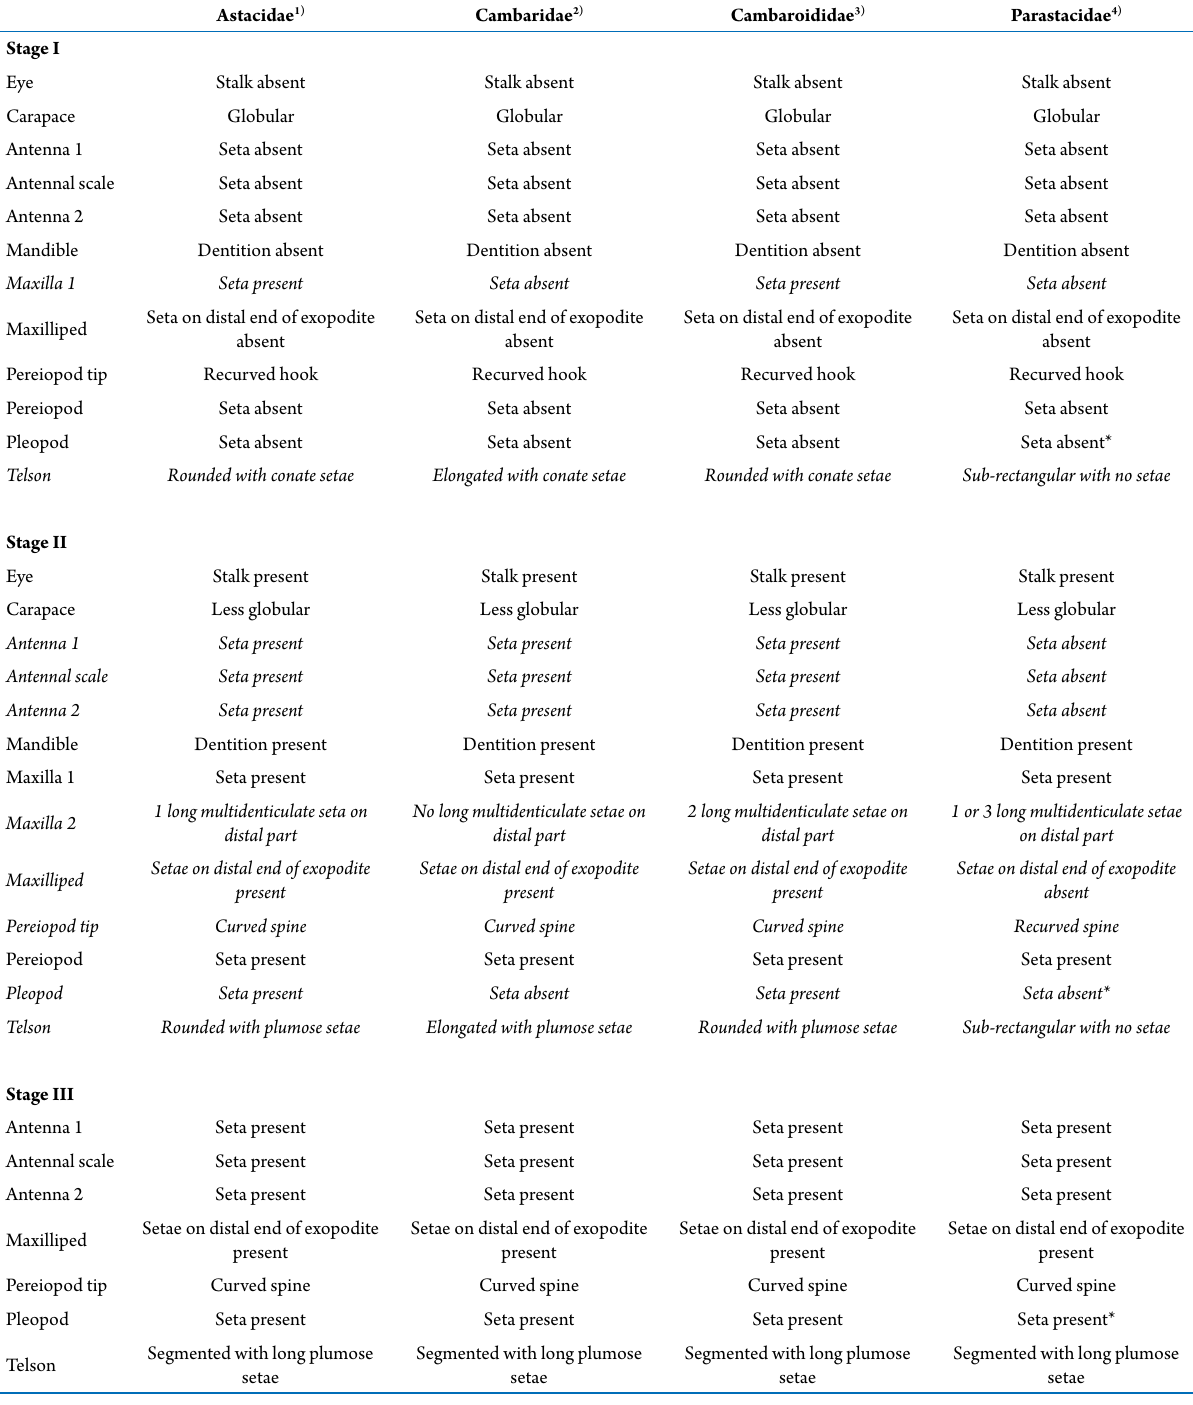
Table 5. Comparison of morphology and seta on appendages of each postembryonic stage in all four families of freshwater